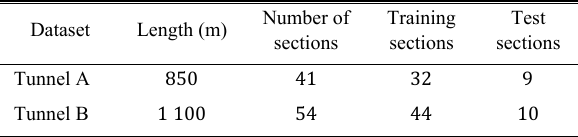
10 Table 1. Parameters of the case study